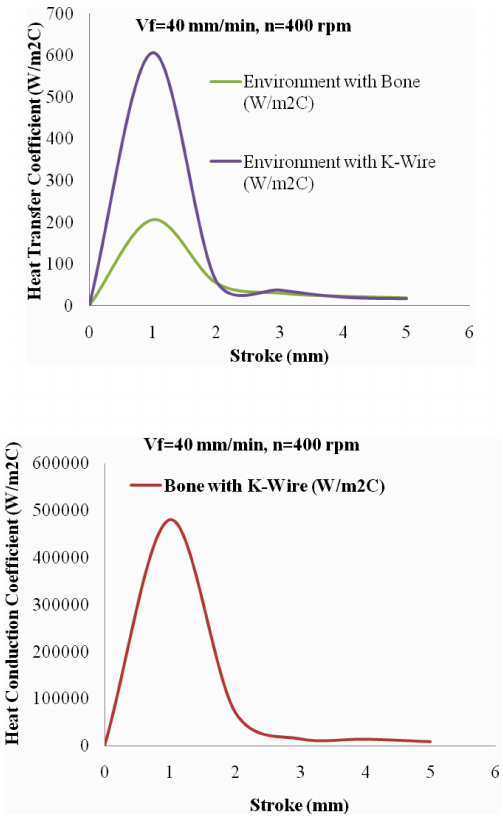
Figure 7. The heat transfer coefficients for each 1mm of the drilling process.